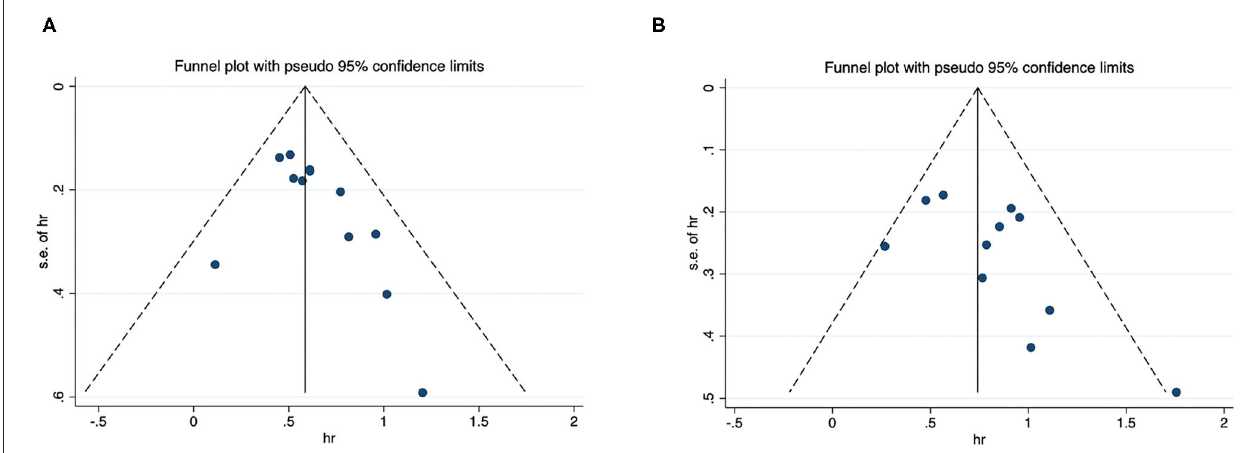
FIGURE 4 | Funnel plot for publication bias. (A) correlation of De Ritis ratio with OS in urological cancers; (B) correlation of De Ritis ratio with CSS in urological cancers.